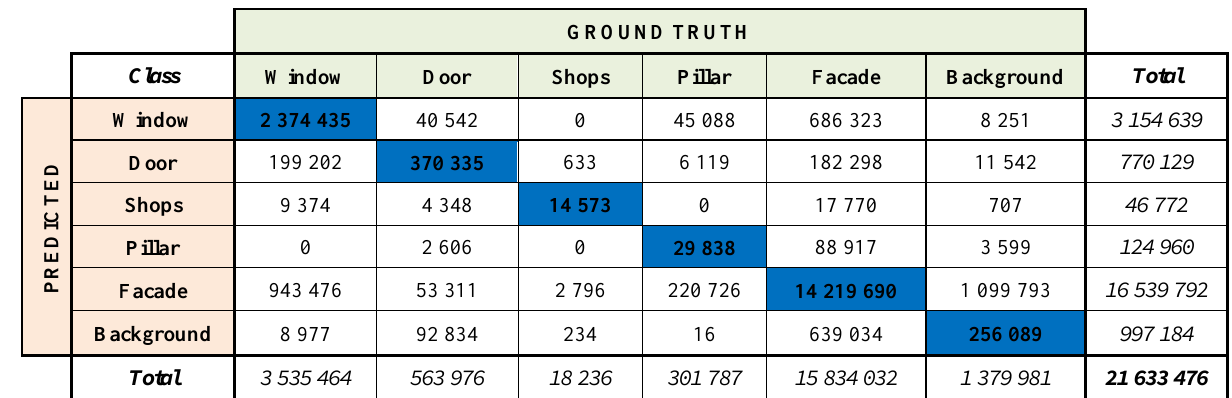
Figure 6. Result of the back-projection to the 3D space: segmented and classified point cloud.